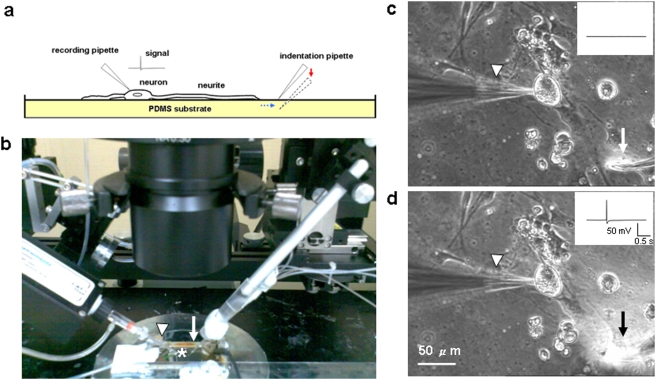
Experimental setup for using elastomeric substrates to probe mechanotransduction in neurites.a,Schematic of the mechanical stretching imposed on neurites in the recording chamber. DRG neurons cultured on a PDMS substrate were recorded with a recording pipette. Force on the neurites was generated by indenting the PDMS substrate with a glass pipette. The force from the indenting pipette was transmitted through the substrate to the cell. The signal from a DRG neuron was recorded through a whole-cell patch clamp set-up. b, An image of the system used to record stretch-evoked AP from neurites. The recording was performed in a recording chamber (asterisk) constantly perfused with ACSF. The neuron was connected to a recording pipette (white arrowhead) that was attached to a pre-amplifier. The neurites were stretched by the pipette (white arrow) indentation that was controlled with a micromanipulator. c, When the indentation pipette (white arrow) was placed on the surface of PDMS substrate near the neurite, no AP was generated (inset). d, As the pipette indented the PDMS through a vertical displacement (micromanipulator), a change in intensity in the differential interference contrast (DIC) image at the location of the pipette was observed (black arrow). This indentation, which imposed a force on the attached cell, evoked an AP (inset).